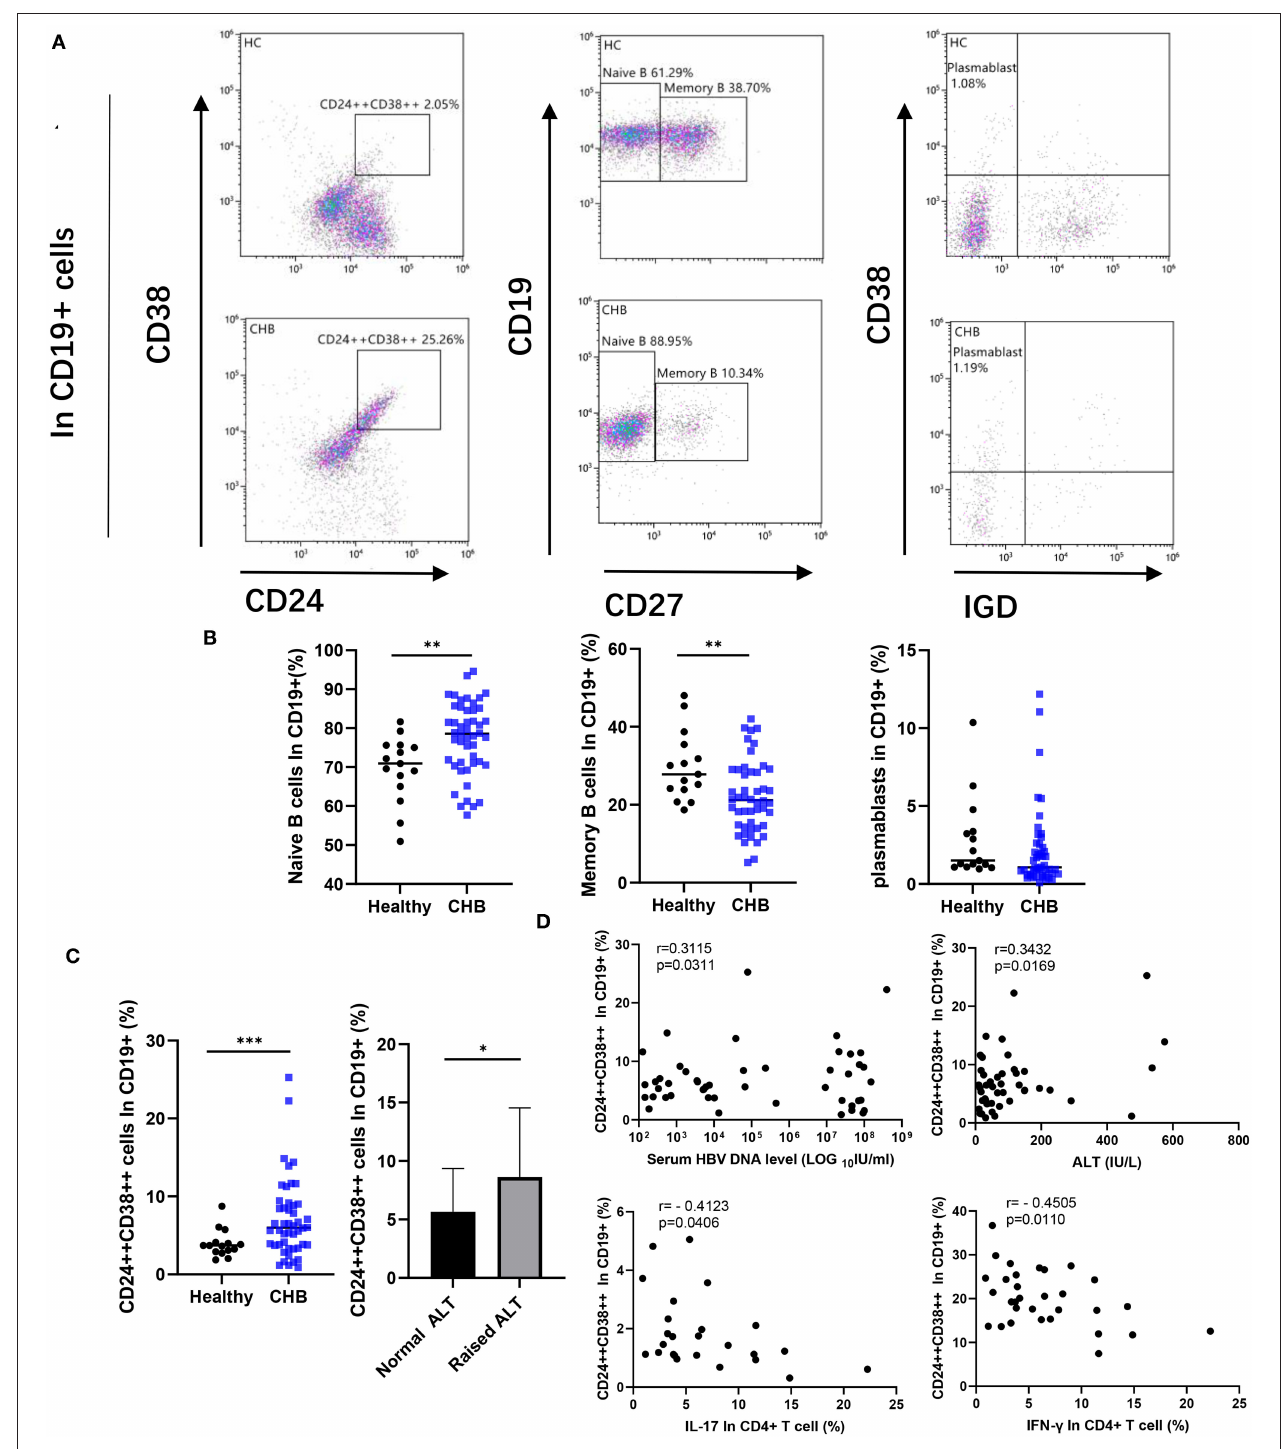
FIGURE 2 | Comparative analysis of peripheral B cell subsets. (A) A representative dot plot of B cell subsets in healthy and chronic hepatitis B (CHB). The cells strongly expressed CD24 and CD38 were defined as Regulatory B cells (Breg). We circled CD19 + CD27– subset as Naïve B cell, and CD19 + CD27 + cells as Memory B cell. The CD19 + CD27 + cells further divided into Plasmablast (CD38 + IgD–) according to the expression of surface marker CD38 and IgD. (B) Percentage of each subset among CD19 + B cells in healthy controls ( n = 15), and CHB ( n = 48) were compared. (C) Percentage of Breg in CHB was compared with the healthy controls, meanwhile the difference between normal ( n = 26) and abnormal alanine aminotransferase (ALT; n = 22) in CHB patients was also showed. (D) The correlation among the Breg, the concentration of ALT, HBV DNA in serum of CHB patient ( n = 48), and cytokines secreted by CD4 + T cells ( n = 31) as shown in the figure. Statistically significant differences are indicated by * p < 0.05; ** p < 0.01; *** p < 0.001.